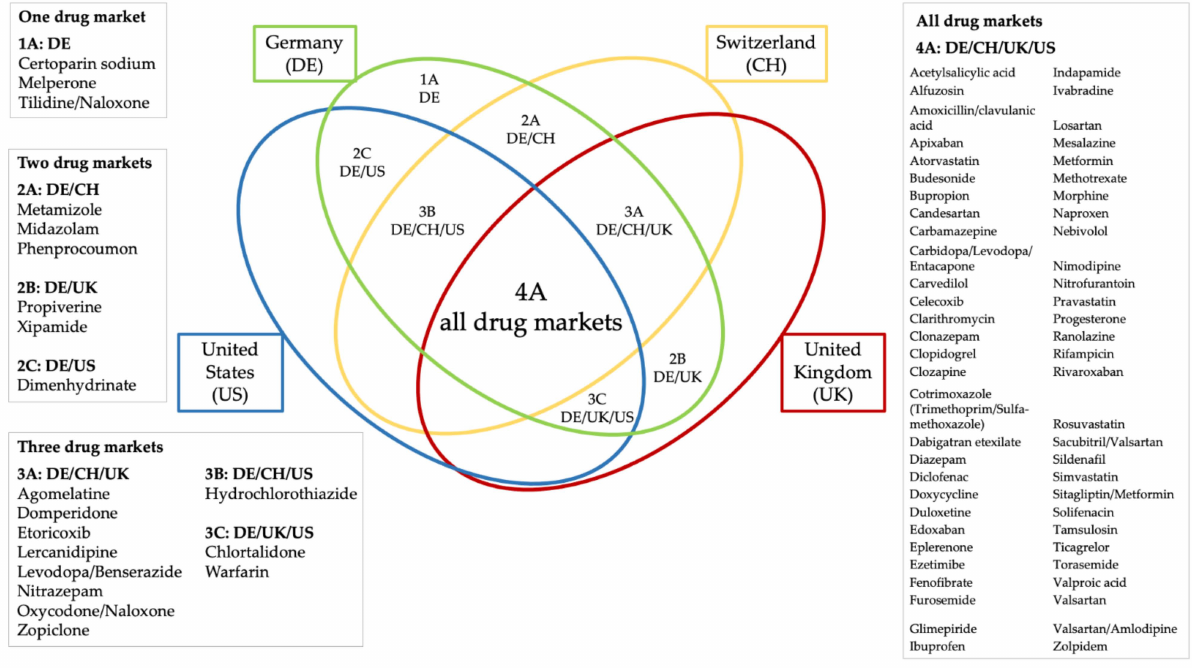
Figure 3. Overlap of active ingredients in the four drug